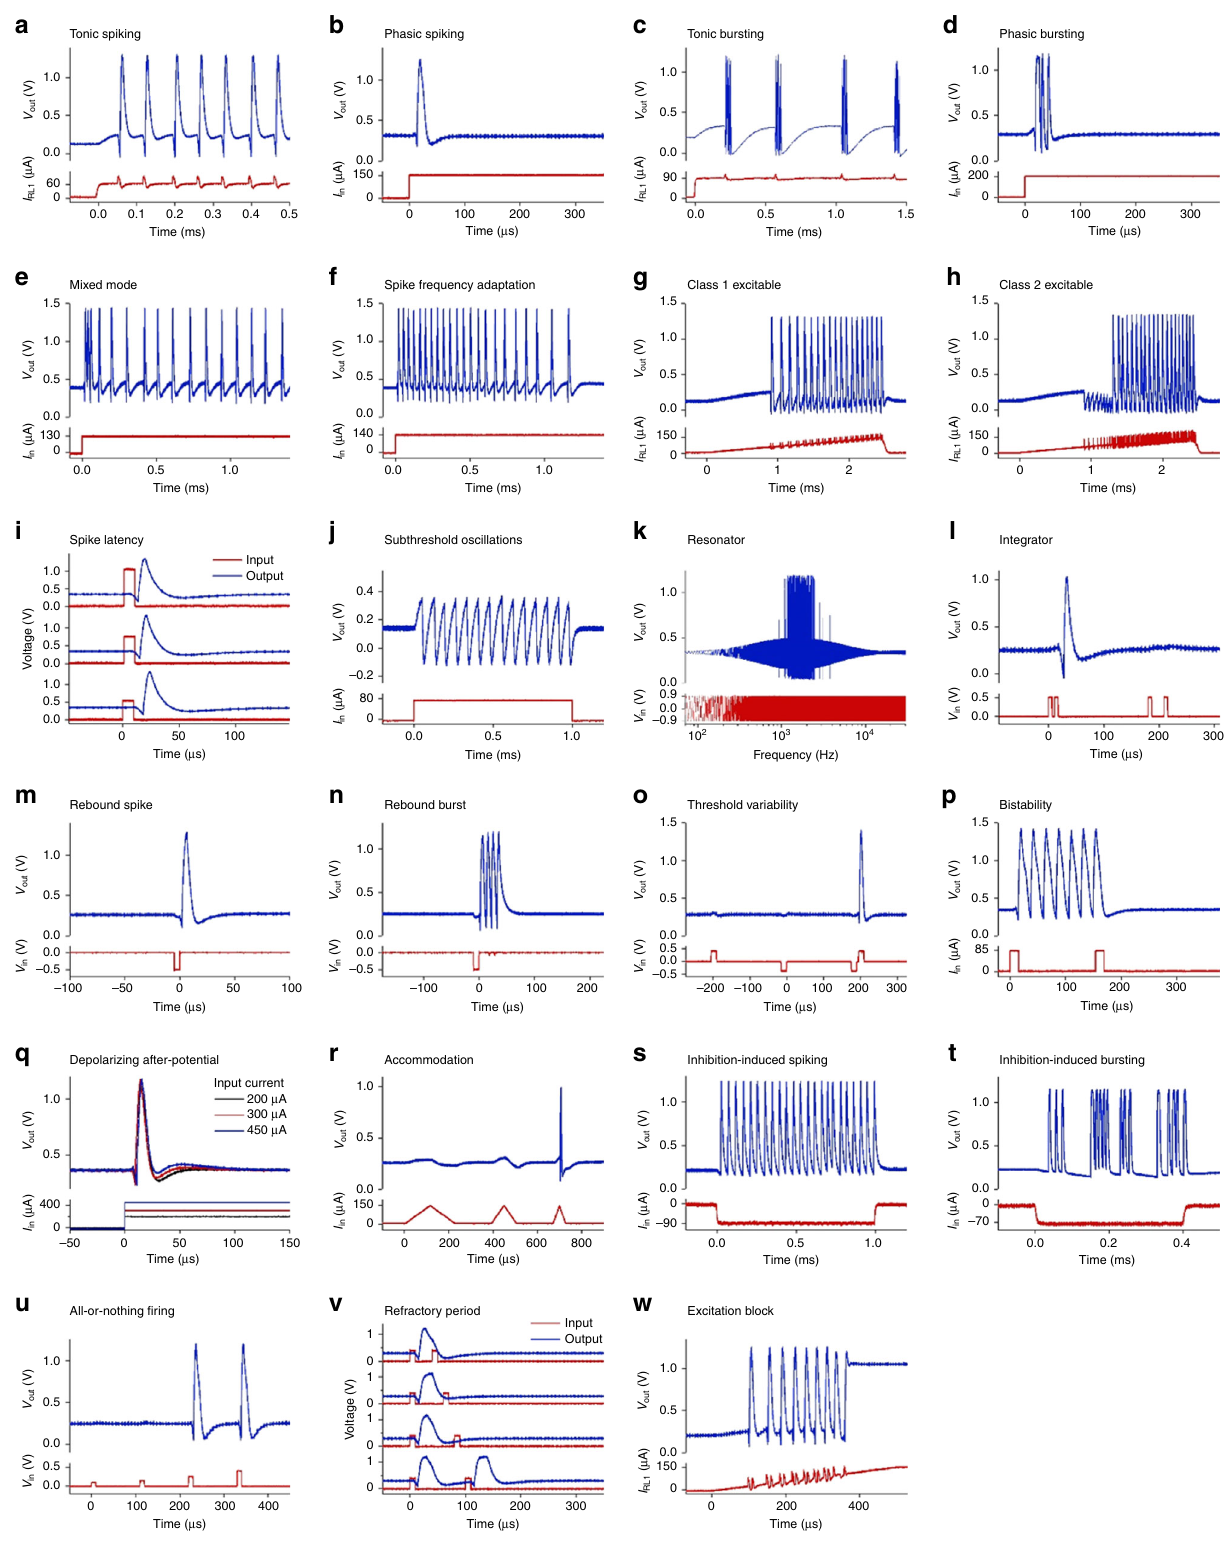
Fig. 4 The 23 biological neuron spiking behaviors experimentally demonstrated in single VO 2 active memristor neurons. a Tonic spiking. b Phasic spiking. c Tonic bursting. d Phasic bursting. e Mixed mode. f Spike frequency adaptation. g Class 1 excitable. h Class 2 excitable. i Spike latency. j Subthreshold oscillations. k Resonator. l Integrator. m Rebound spike. n Rebound burst. o Threshold variability. p Bistability. q Depolarizing after- potential. r Accommodation. s Inhibition-induced spiking. t Inhibition-induced bursting. u All-or-nothing fi ring. v Refractory period. w Excitation